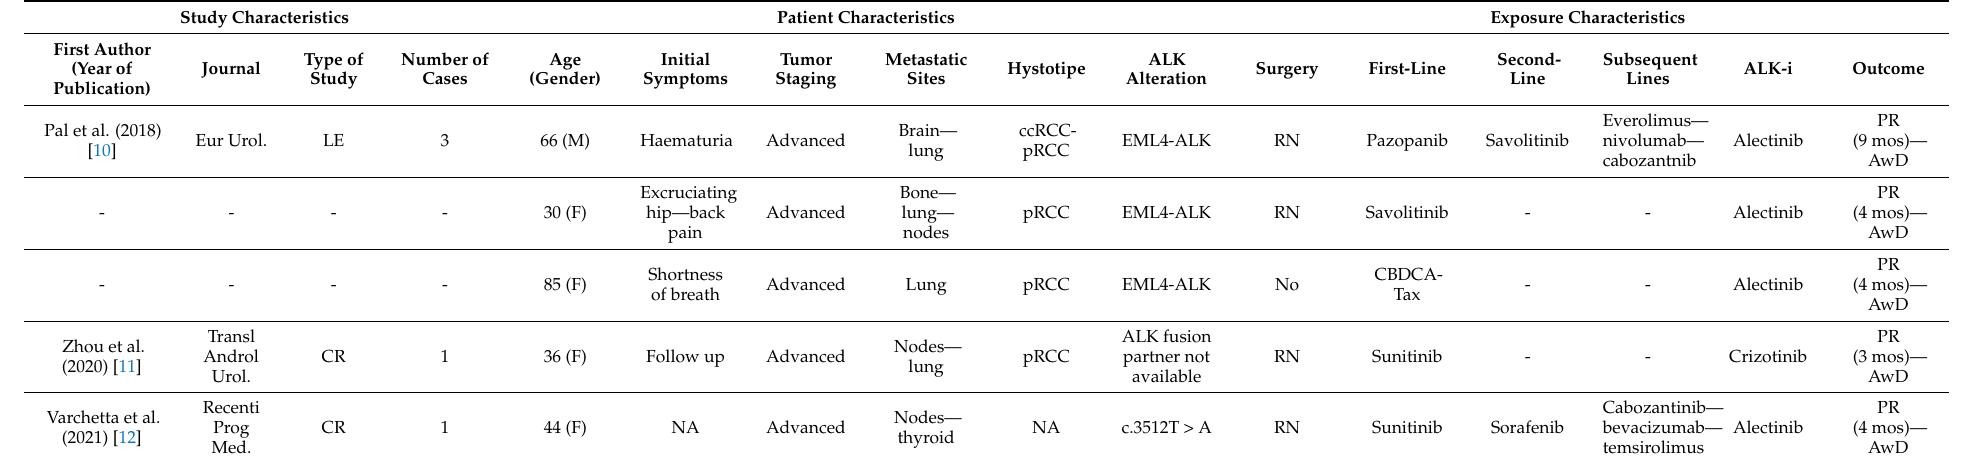
Table 1. Variables extracted from included